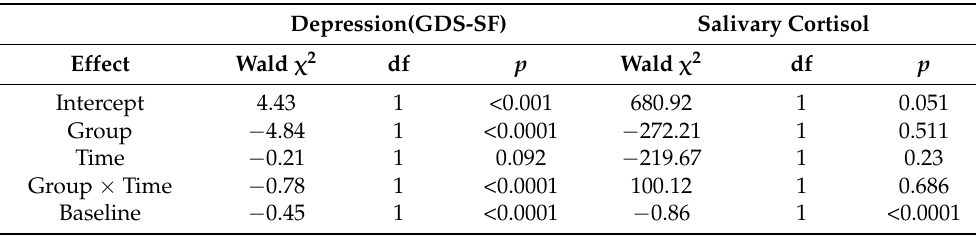
Table 3. GEE model results for depression (GDS-SF) and salivary cortisol by group and time interac- tion ( N = 58).